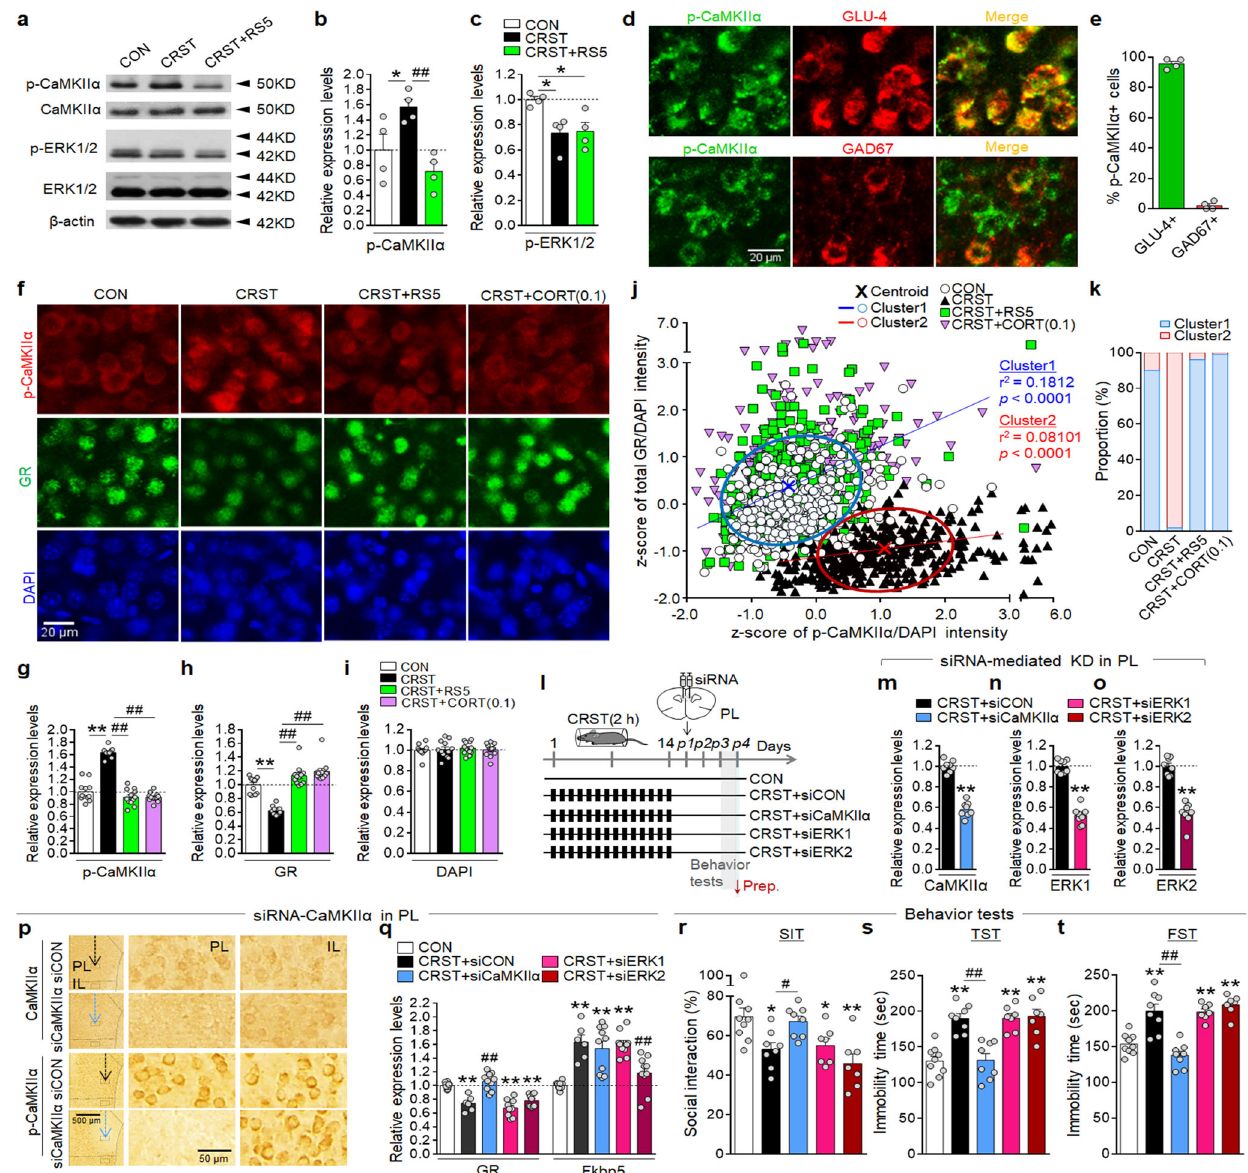
Fig. 6 RS5 restores increased p-CaMKII α expression in PL neurons. a – c Western blots showing expression levels of p-CaMKII α , CaMKII α , p-ERK1/2, ERK1/2, and β -actin in the PL of the indicated groups ( a ). Quanti fi cation levels of p-CaMKII α ( b ) and p-ERK1/2 expression ( c ). Western blots were representative of four technical repeats carried out using two sets of the indicated groups, each set with tissue samples from three pooled animals per group. β -actin was included as an internal loading control. d , e Immuno fl uorescence staining of p-CaMKII α (green) in PL neurons stained with GLU-4 (a marker of glutamate neurons; red) or GAD67 (red) ( d ) and their quanti fi cation levels ( e ) ( n = 4 per group). f – k Immuno fl uorescence images showing p-CaMKII α (red) and total GR (green) expression in PL neurons of the CON, CRST, RS5, and CORT (0.1 mg kg − 1 ) groups ( f ). DAPI, blue. Quanti fi cation levels of p-CaMKII α ( g ), GR ( h ), and DAPI intensity ( i ) ( n = 4 – 6 animals per group). Two distinct clusters with differential expression of p-CaMKII α and total GR across individual cells of the indicated groups ( j ) and the % composition of individual cells of each group in the clusters ( k ) ( n = 345 – 390 cells from 4 – 6 animals per group). l – t Experimental design ( l ). Transcript levels showing siRNA-mediated knockdown of CaMKII α ( m ), ERK1 ( n ), and ERK2 ( o ) in the PL of CRST-treated mice. Immunohistochemical images showing siRNA-mediated knockdown of CaMKII α and p-CaMKII α in siRNA injection sites ( p ). Transcript levels of GR and Fkbp5 ( q ) in the PL for the indicated groups ( n = 4 – 8 animals per group, 3 – 5 repeats). The % time of social interaction in the SIT ( r ), and immobility time in the ( s ) and FST ( t ) for the indicated groups ( n = 7 – 9 animals per group). Data were mean ± SEM. Gray circles represent individual data points. *, the difference compared to control; #, the difference compared to CRST. *, #, p < 0.05, **, ##, p < 0.01 (Two-sided Student ’ s t -test; one-way ANOVA followed by Newman – Keuls post hoc test). See Supplementary Data 4 for statistical